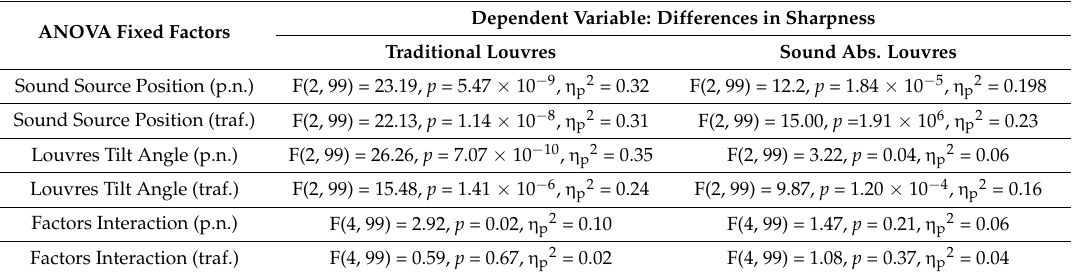
Table A3. Two-way Factorial ANOVAs results referred to the differences in Sharpness.